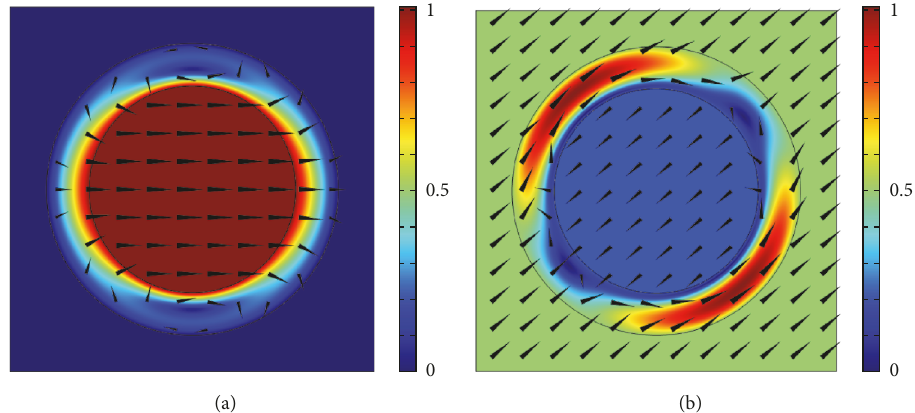
Figure 3: Vibration modes at lower edge (a) and upper edge (b) of the first band gap of the single-oscillator acoustic metamaterial system. The color bar represents the normalized